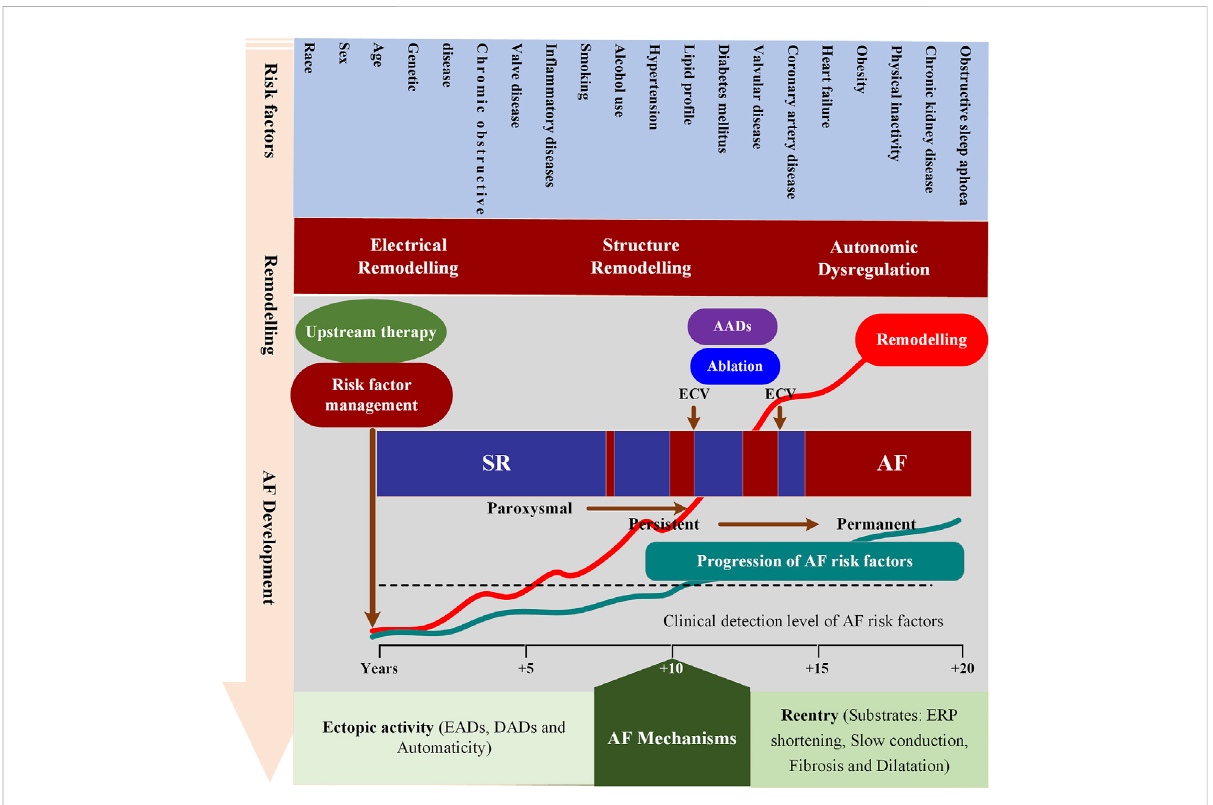
FIGURE 1 SchematicoverviewofmechanismsunderlyingAFdevelopmentandprogression.This fi guredepictstheinterrelationshipsbetweenriskfactors, time-dependent atrial remodeling and progression from sinus rhythm (SR) through paroxysmal and persistent to permanent AF. ECV = electrical